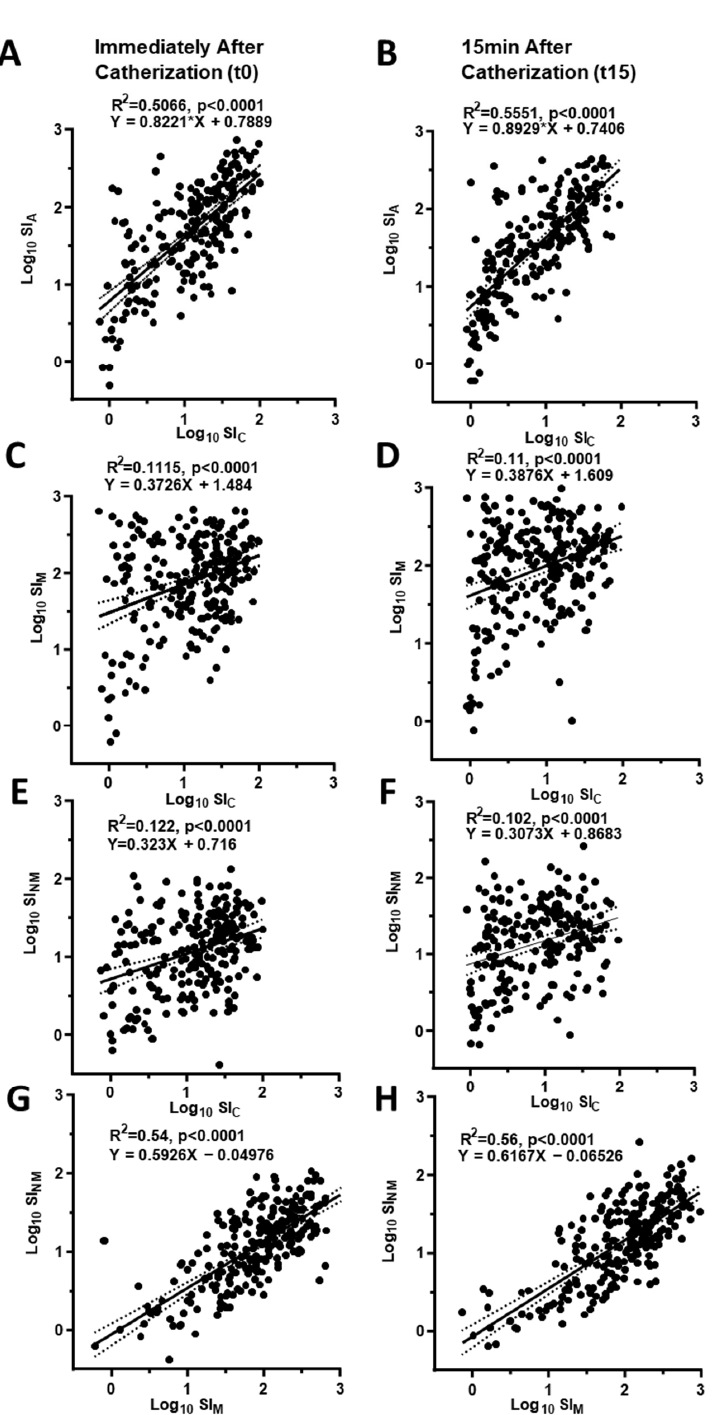
Figure 1. The scatter plots show the relationship between the log10-transformed values of the selectivity index calculated from cortisol (SI C ) and androstenedione (SI A ) immediately after starting catherization (Panel A ) and after 15 min (Panel B ). Similar plots illustrate the correlation of SI C with SI calculated from metanephrine (SI M , Panels C and D ) and normetanephrine (SI NM , Panels E and F ). The relationship between SI M and SI NM is also shown (Panels G and H ). Please note that the correlation between the steroids (Panels A and B ), and between the metanephrines (Panels C and H ) was tighter than between steroids ad